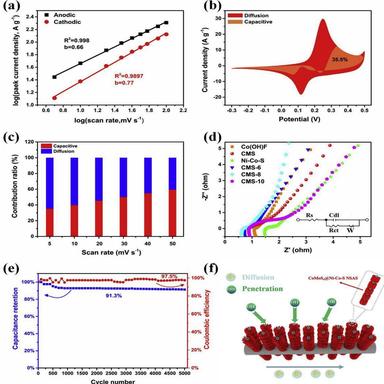
(a) Logarithm relationship between peak current density and scan rate and (b) Capacitance-dominated and diffusion-controlled contribution to charge storage of CMS-8 at a scan of 5 mV s1 ; (c) The charge storage contribution for CMS-8 at different scan rates; (d) EIS spectra for the Co(OH)F, CMS, NieCoeS, CMS-6, CMS-8 and CMS-10 electrodes. Insets: equivalent circuit for the Nyquist plots; (e) Cycling performance of CMS-8 electrode at a current density of 3 A g1 . (f) Schematic illustration of the hierarchic